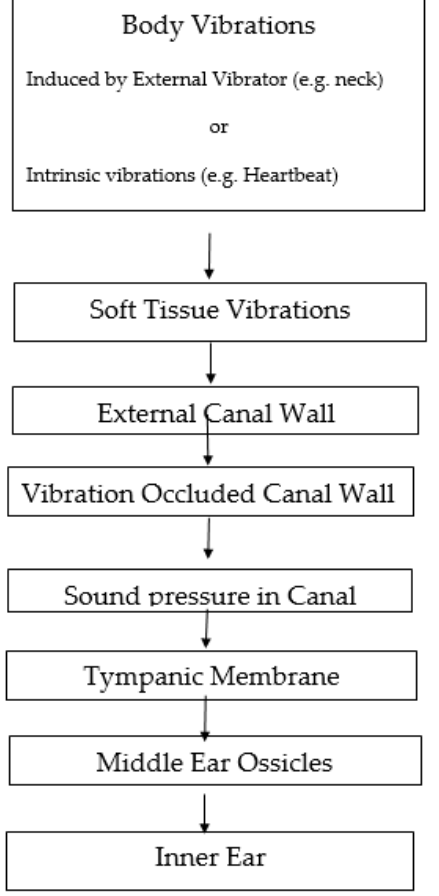
Figure 1. Schematic diagram showing the suggested mechanism of the final stage of hearing in response to soft tissue conduction: the vibrations of the soft tissues (initiated either by an external vibrator, for example, at the neck or by intrinsic body vibrations, e.g., heartbeat) elicit the occlusion effect, which produces sound pressure in the occluded external canal, and drive the tympanic membrane and the ossicular chain. Therefore, the inner ear is excited by a pathway similar to that in response to AC stimulation.